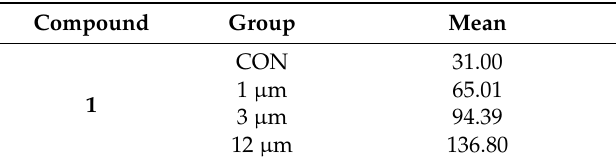
Table 5. Effect of compound 1 on calcium in HepG2 Cells.